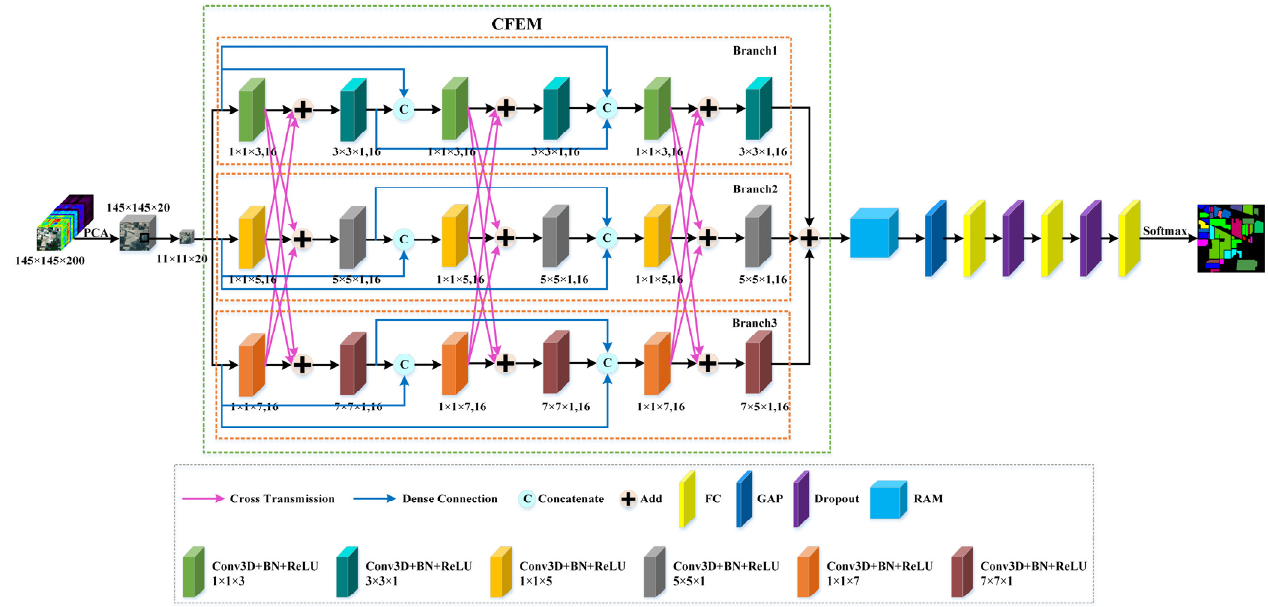
Figure 5. Overall network model.